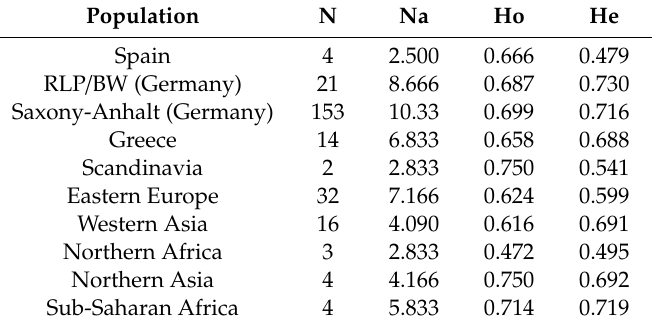
Figure 4. Graphic representation of Bayesian cluster analysis conducted in a structure based on six microsatellite loci performed with a K from 2 to 6. Population names are provided under the graphics. Each individual is represented by one vertical line and the colors point toward the probability of belonging to each of the genetic clusters. The estimated number of clusters obtained through the Bayesian cluster analysis, in a structure using the Δ K method, was six clusters. Overall, the different sampled bee-eater populations share